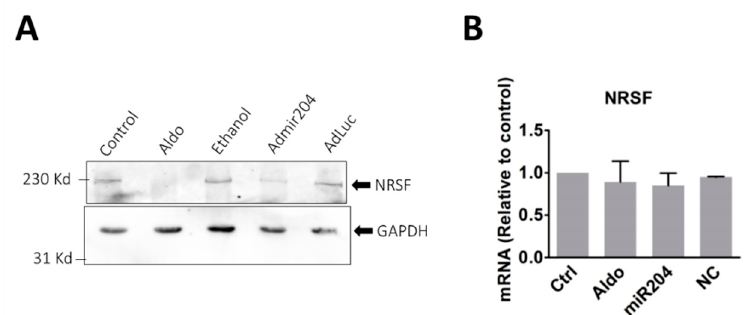
Figure 7. Aldosterone stimulation and miR-204 overexpression reduce REST-NRSF protein expression. ( A ) The pictures represent immunoblotting which shows the expression of REST-NRSF (upper panel) and GAPDH (lower panel) detected with specific antibodies. Cardiomyocytes were incubated for 24 h with either 1 µ M aldosterone (Aldo) or ethanol (1 µ L), or infected with miR-204 adenovirus (AdmiR204), or shLuc adenovirus (AdLuc) for the same period. The picture is representative of three experiments performed from three different cell preparations. ( B ) The bar graph shows the mRNA expression level of the transcriptional repressor NRSF determined by RT-qPCR in control, aldosterone (1 µ M), miR204 adenovirus infected or shLuc adenovirus infected cardiomyocytes. The bars and error bars indicate the means + SEMs ( n = 3).